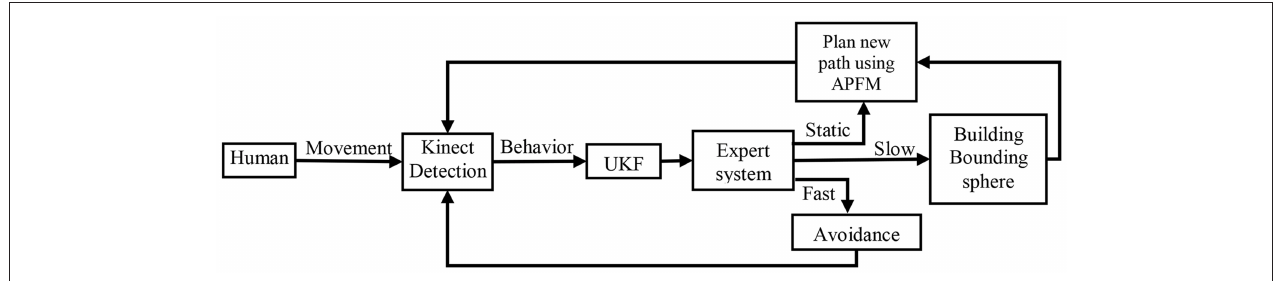
FIGURE 1 | Process chart of the proposed method.